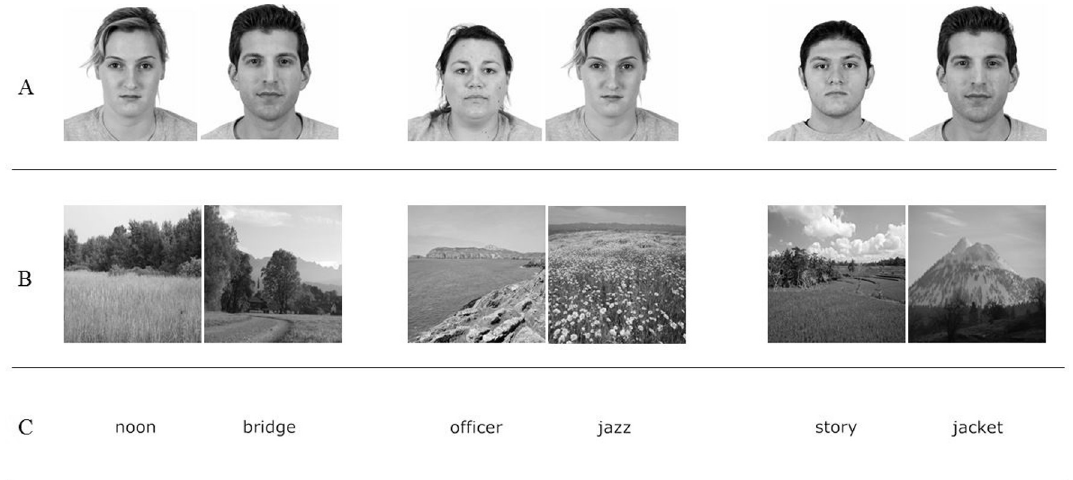
Fig 1. Experiment 3: Example stimuli pairs for faces (Panel A), places (Panel B), and words (Panel C).